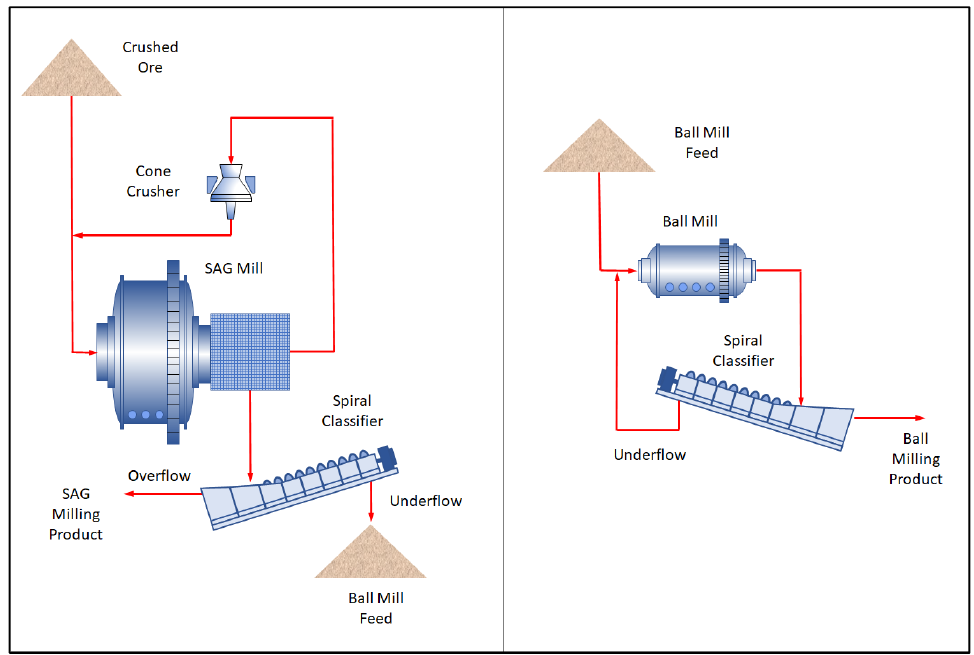
Figure 2. Circuit configurations adopted in the pilot plant campaign.